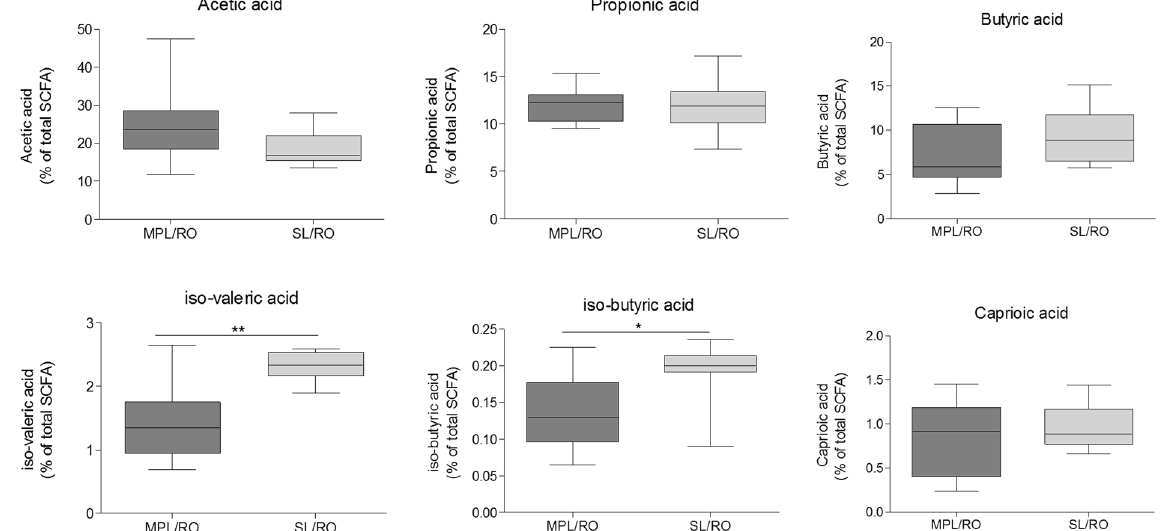
Figure 4. Effect of emulsifier on short-chain fatty acid (SCFA) production in cecum of mice at Day 14 after emulsion consumption. Levels of SCFAs are illustrated as percentages of total SCFAs. ( A ) Acetic acid, ( B ) Propionic acid, ( C ) Butyric acid, ( D ) iso-valeric acid, ( E ) iso-butyric acid, and ( F ) Caprioic acid. Differences between groups were calculated using unpaired t-test with Welch correction. Asterisks indicate significant differences ( * p < 0.05, ** p < 0.01). MPL: Milk phospholipids, RO, Rapeseed oil, SL: Soy